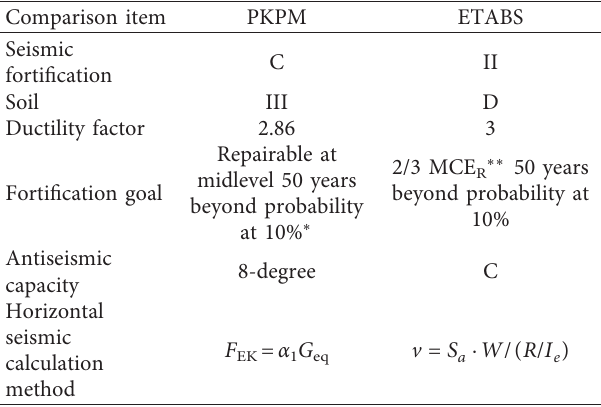
Table 4: Comparison of main seismic load parameters between PKPM and ETABS.